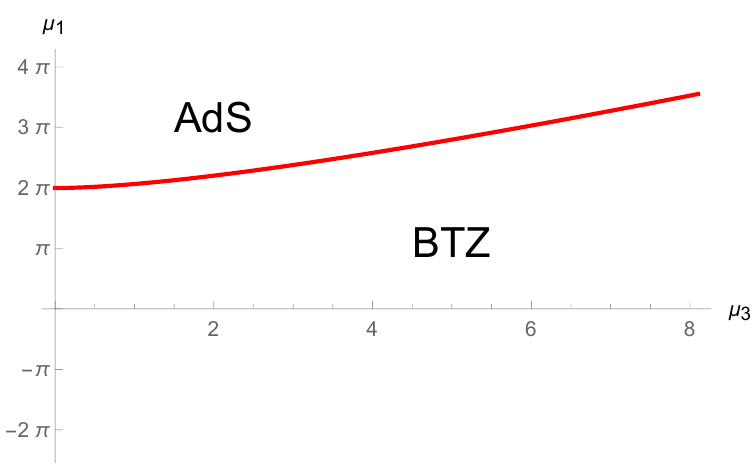
Figure 1 . The phase-diagram on (cid:22) 3 - (cid:22) 1 plane with (cid:22) 3 (cid:21) 0. (Euclidean) BTZ is the leading contribution to the generalized partition function (6.7) in the region below the red curve. In particular, BTZ is always the leading saddle for non-positive (cid:22) 1